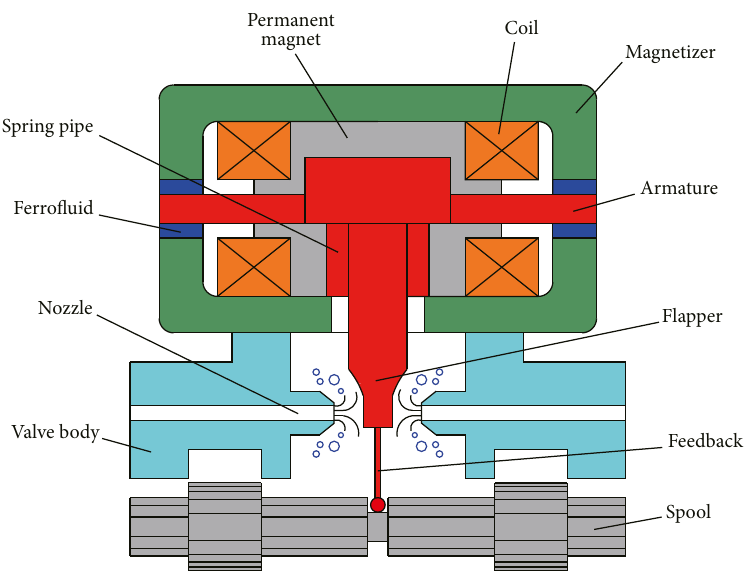
Figure 1: Structure of electric-hydraulic servo valve with